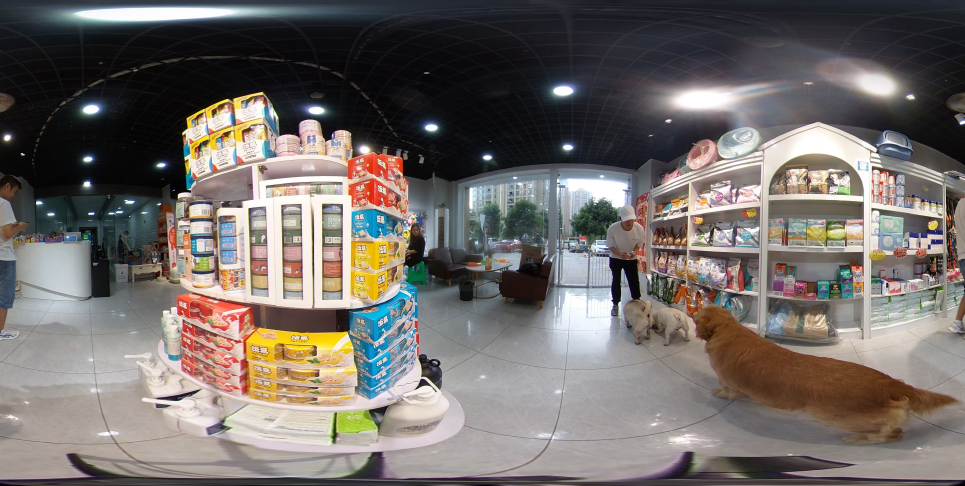
Figure 1. The image captured by the 360° fisheye camera is transformed by equirectangular